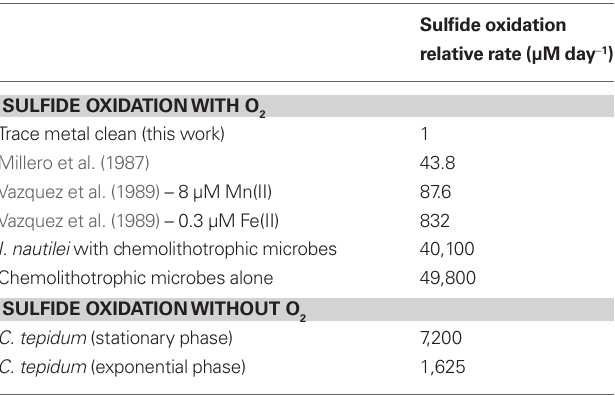
Table 3 | Comparative rates for the oxidation of sulfide under abiotic and biotic conditions.